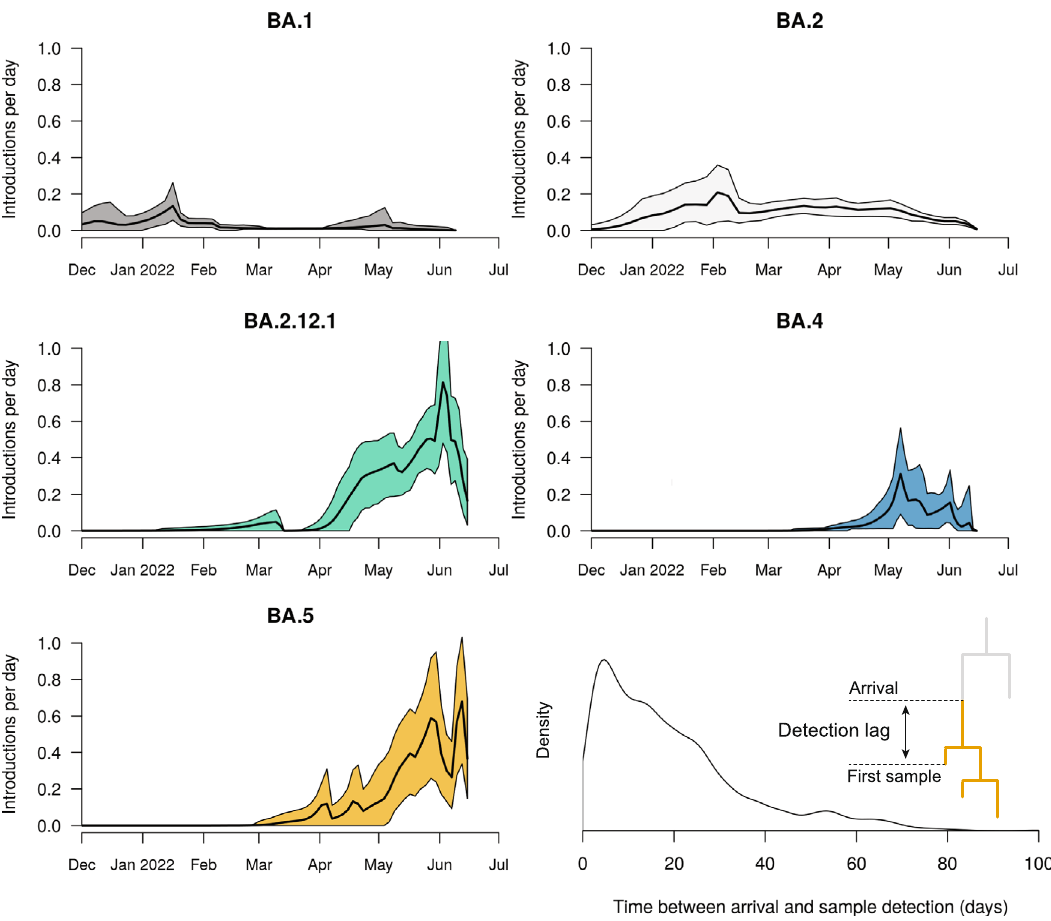
Fig. 5 | Estimated arrival rate of Omicron subvariants into New Zealand. Mean estimates (black line) and 95% credible intervals (shaded) are indicated. Bottom right:Lagtimebetweenwhenalineageisestimatedtohaveenteredthecommunity